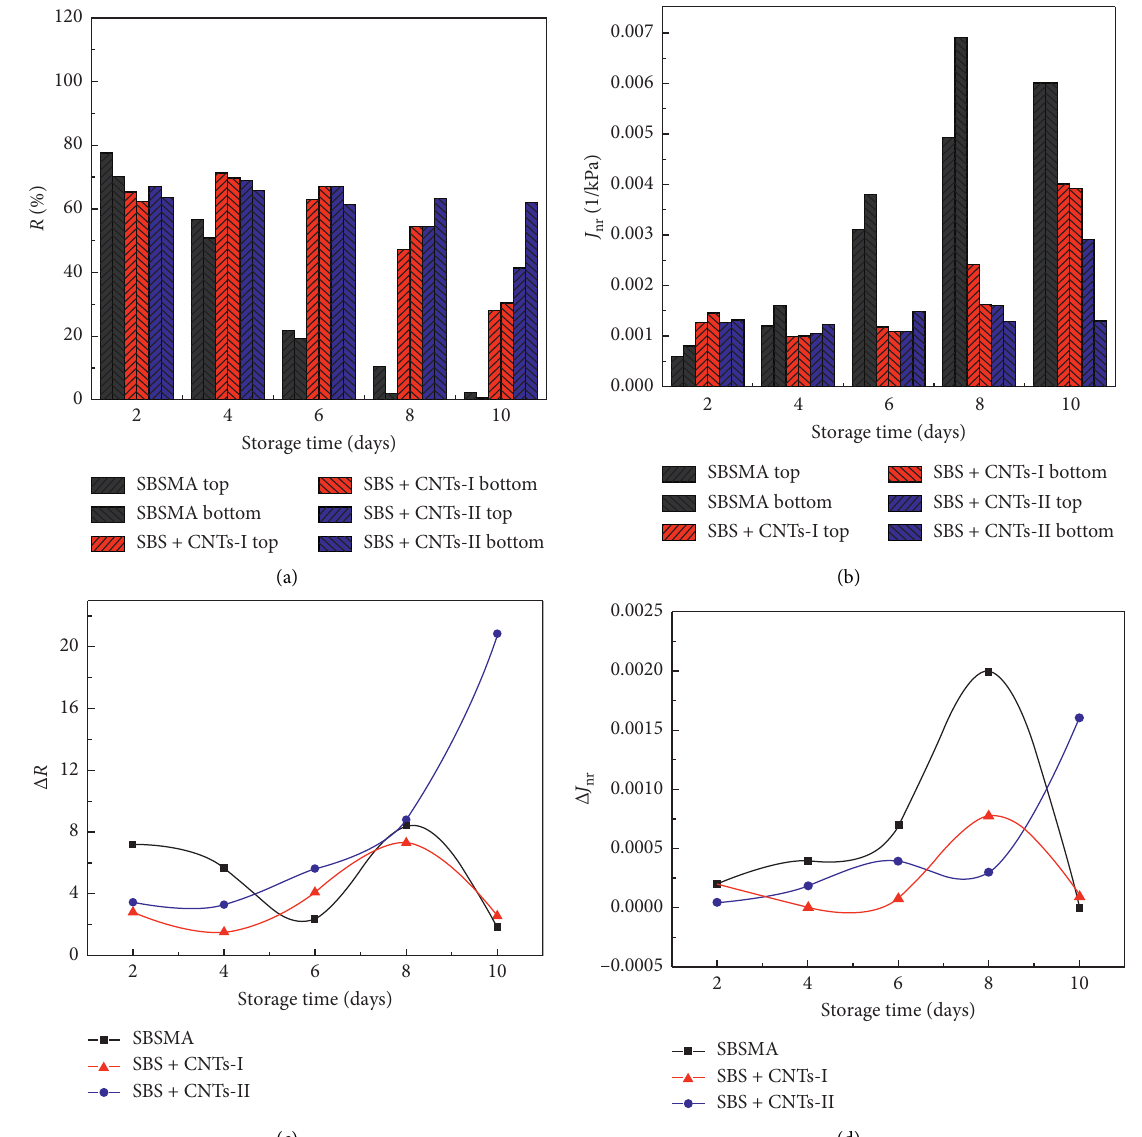
Figure 9: R , J nr , Δ R , and △ J nr of three kinds of modified asphalt with different storage times. (a) R , (b) J nr , (c) Δ R , and (d) △ J nr for different storage